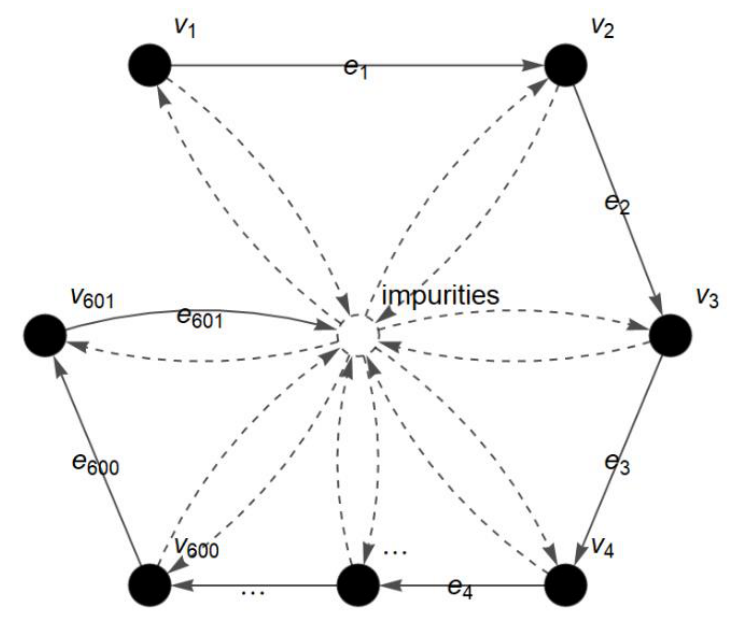
Figure 6. FACS graph of coffee spectrum at 1600–1000 cm −1 region. Table 4. Dominant wavenumbers for Arabica and